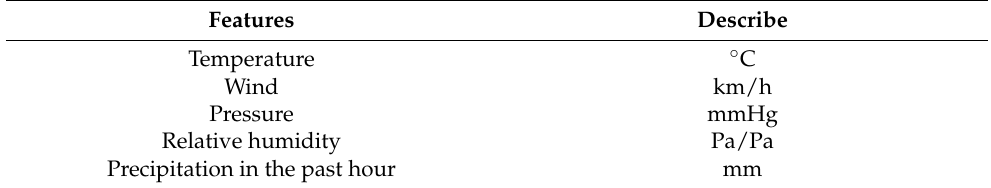
Table 3. Formats of weather data